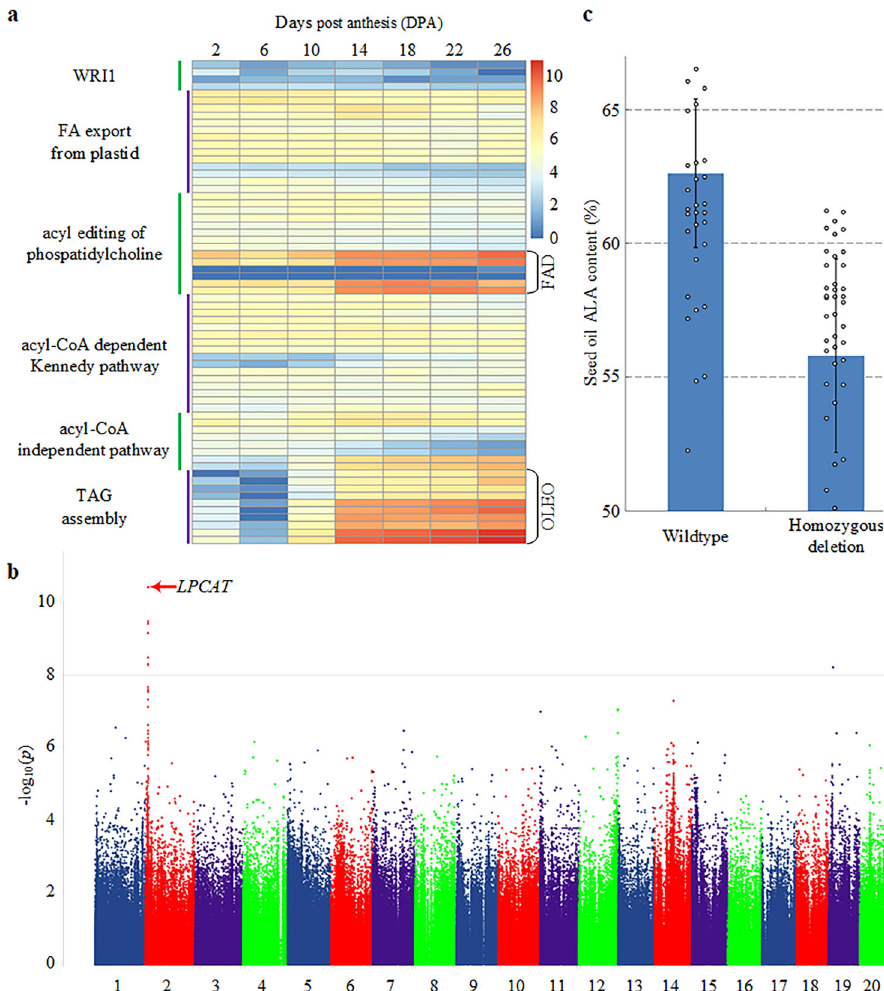
Fig. 6 Analysis of perilla seed oil biosynthesis genes. a Expression heatmap of TAG biosynthesis genes during perilla seed development. TPM values of TAG genes were extracted from seven transcriptomes corresponding to the seeds of 2, 6, 10, 14, 18, 22, and 26 days post anthesis (DPA) of the high oil content line PF40 (~56%), and displayed as log2(TPM + 1). Each row represented one predicted TAG-related genes in PFA-PFB alternating manner. The